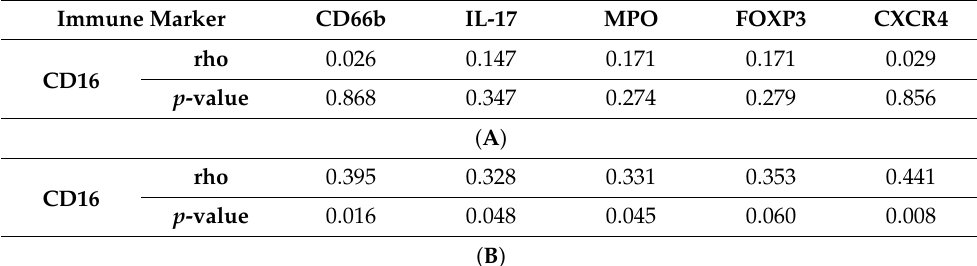
FIGO stage: IIIA